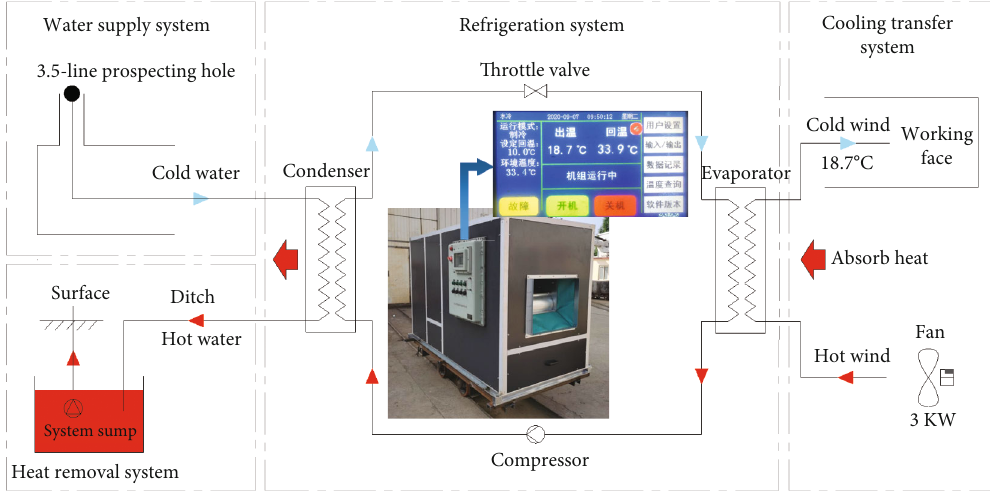
Figure 5: Principle and operation of the cooling system. Table 1: Technical parameters of